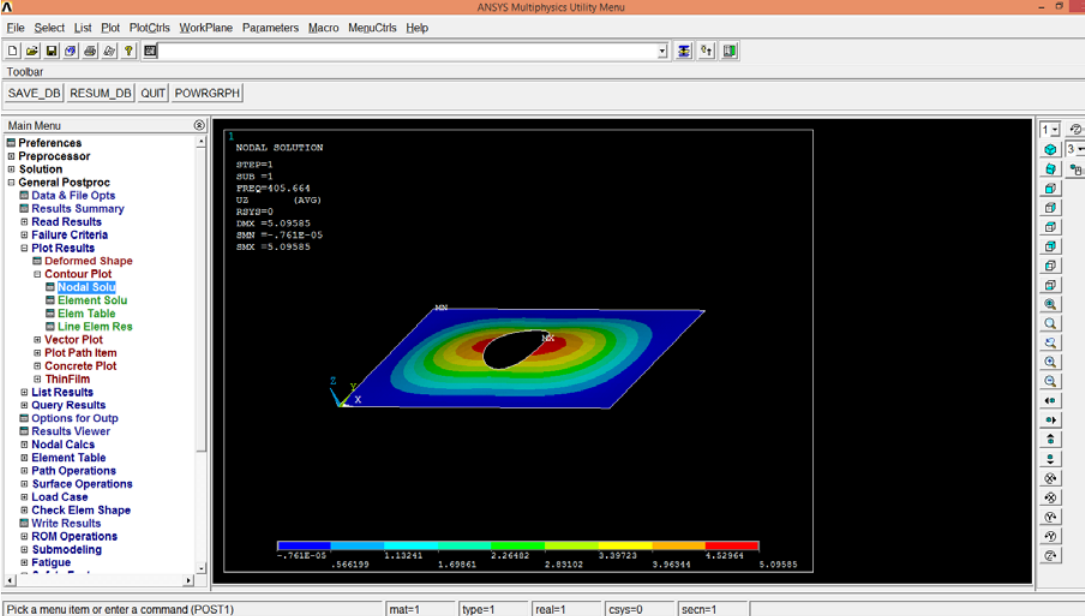
Figure 8: Plate with circular hole CCCC condition